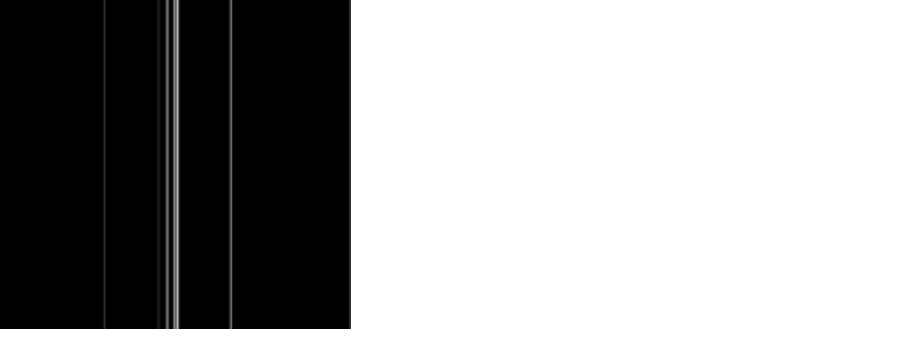
Figure 19. The 3D radar pointcloud is projected into 2D grayscale lines with 16-bit depth.